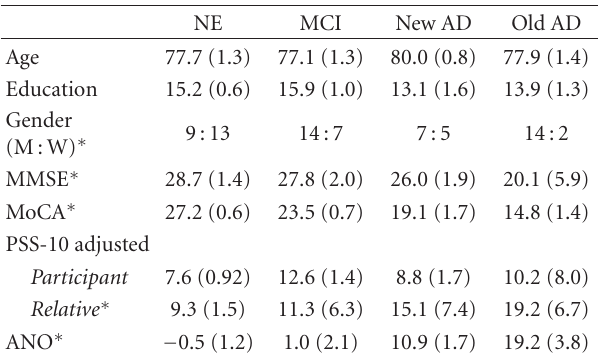
Table 1: Demographic information for the normal elderly, individ- uals with Mild Cognitive Impairement, newly diagnosed, and long- lasting Alzheimer’s disease